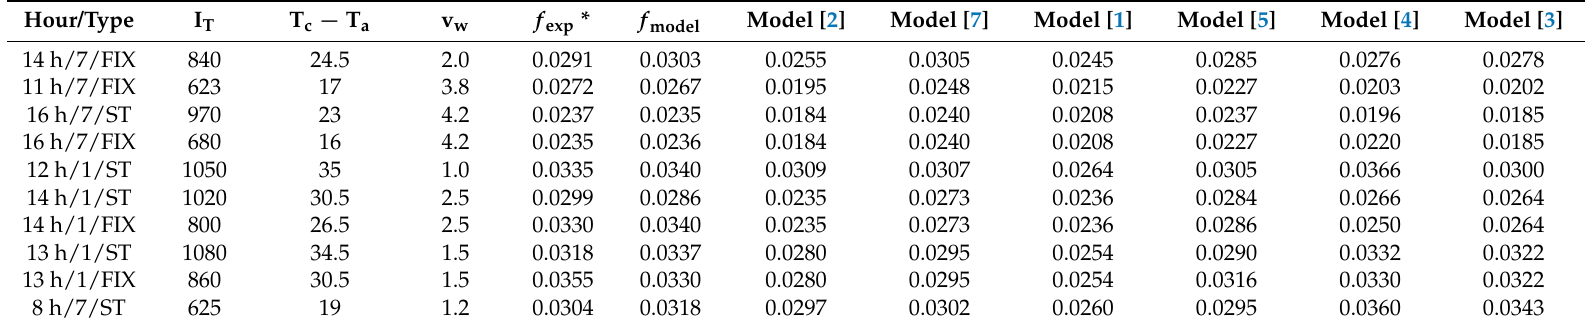
Table 4. The predicted by this model f values compared with those calculated using models [1–5,7] and the experimentally determined ones, for various hours of a mid-day of January and July under various environmental conditions, I T and v w . Both cases of FIX and ST PV systems were